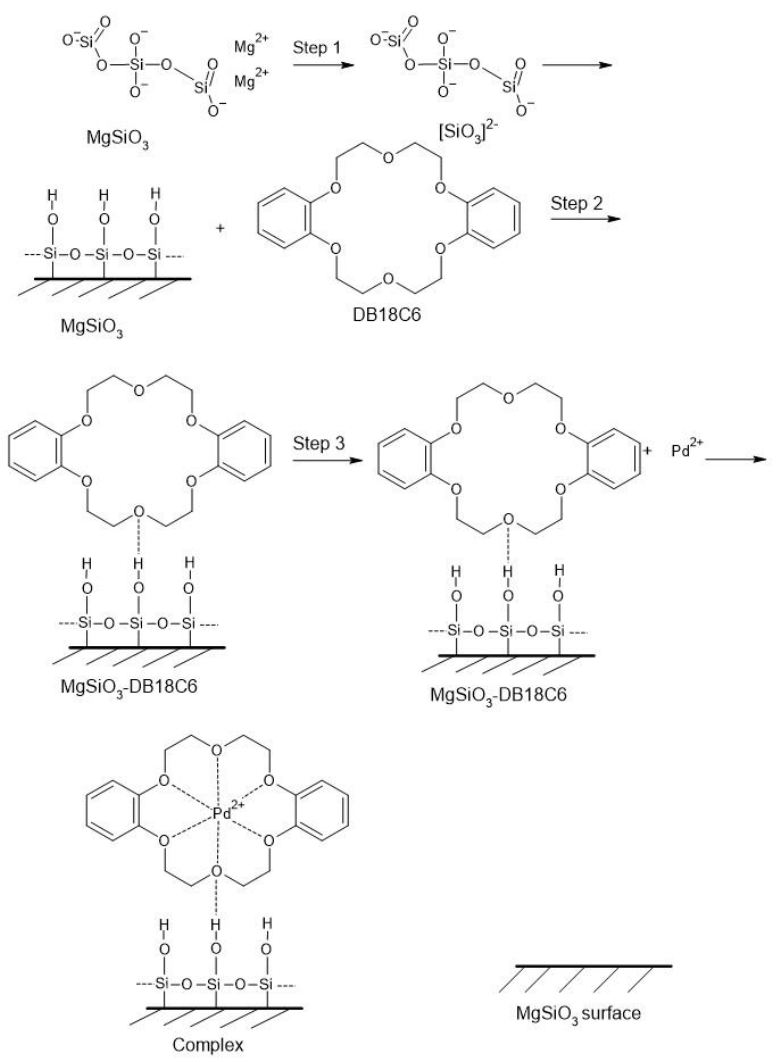
Figure 15. Mechanism for MgSiO 3 -DB18C6.